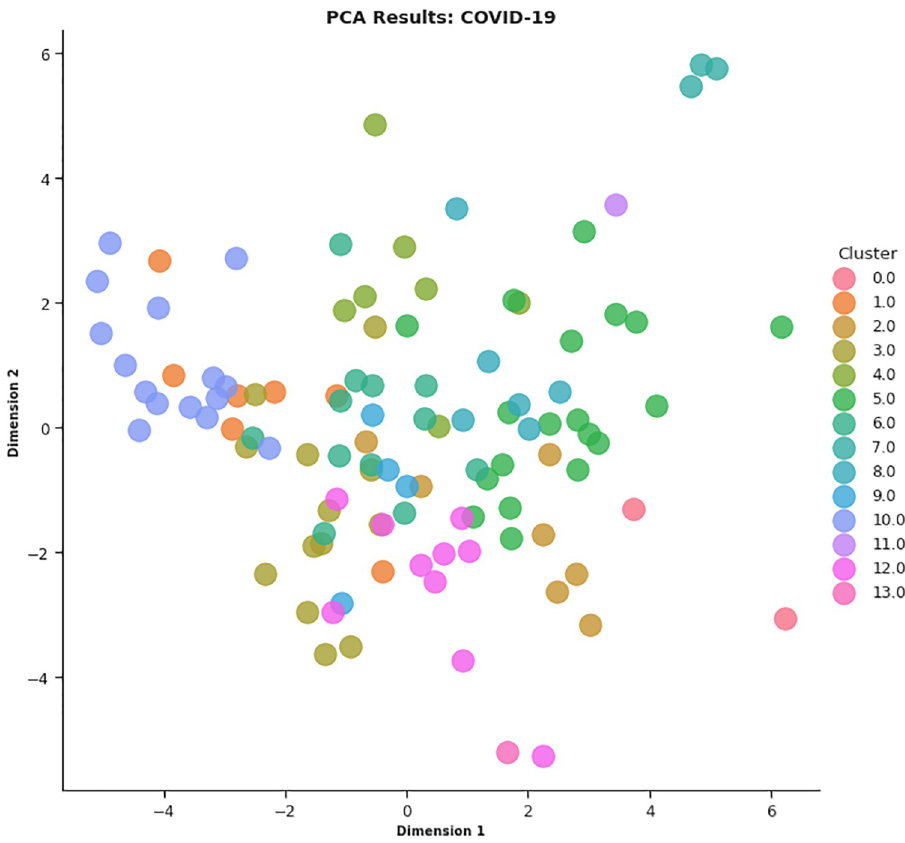
Fig 29. PCA visualization of clusters for